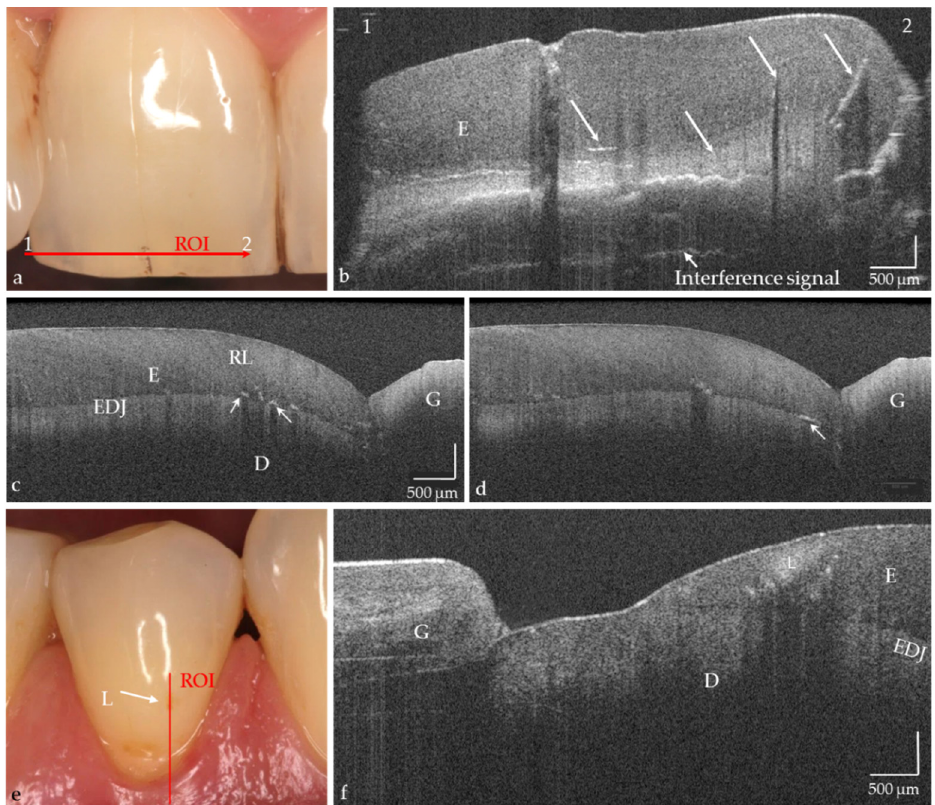
Figure 4. In vivo imaging of hard tooth tissues ( a – f ), intrinsic structures, and defects in enamel (( b – d ), arrows). Partially also Retzius lines (RL; ( c )) and superficial tissue structures of the gingiva ( f ) are indicated. ( e ) Premolar with vestibular brown discoloration. The OCT cross-sectional image ( f ) showed that besides the discoloration a carious lesion in enamel (L) is present. The lesion body appears as a bright zone with clear shadowing. Scales are related to refractive index n = 1.0. While the horizontal scale in an OCT cross-sectional image is independent of the refractive index (n) of the tooth structures, the length of the vertical scale has to be divided by it (mean n for enamel and dentin approx.